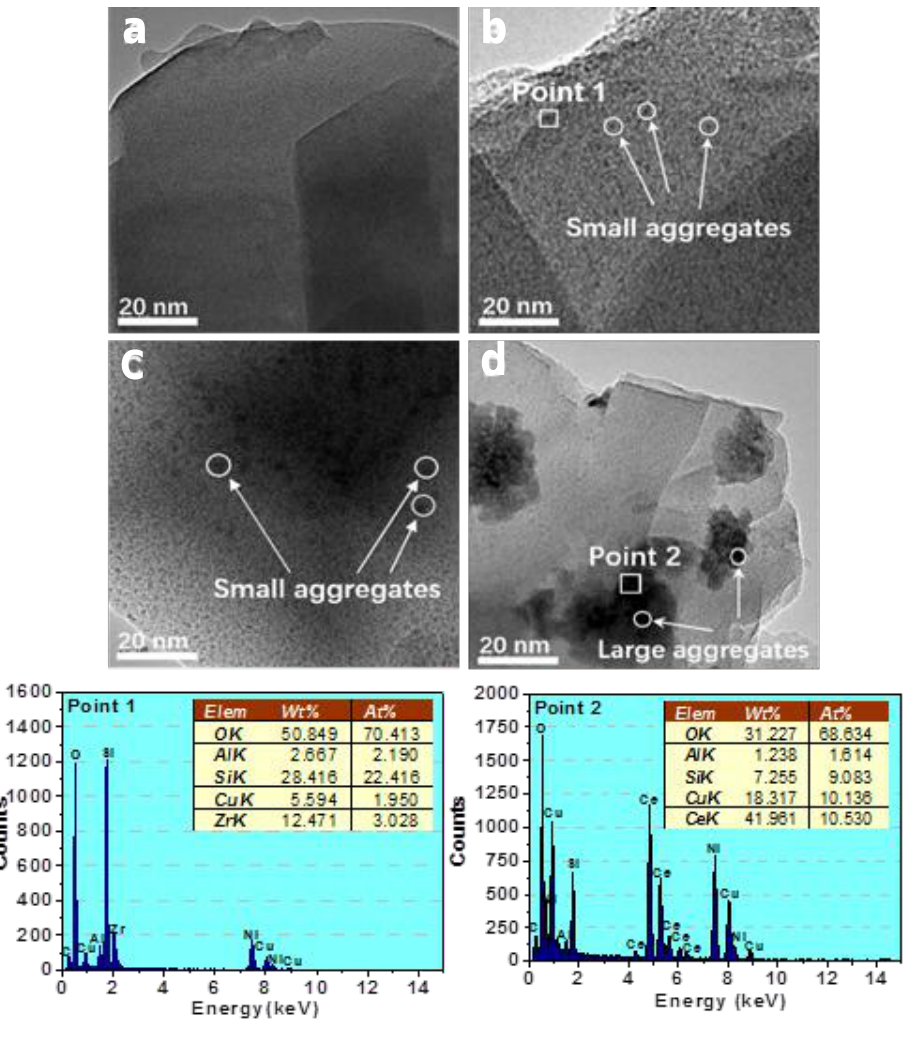
Figure 3. TEM images and energy-dispersive X-ray (EDX) quantitative analyses for ( a ) ZSM-5, ( b ) CuZr 1 /ZSM-5, ( c ) CuCe 0.5 Zr 0.5 /ZSM-5, and ( d ) CuCe 1 /ZSM-5.